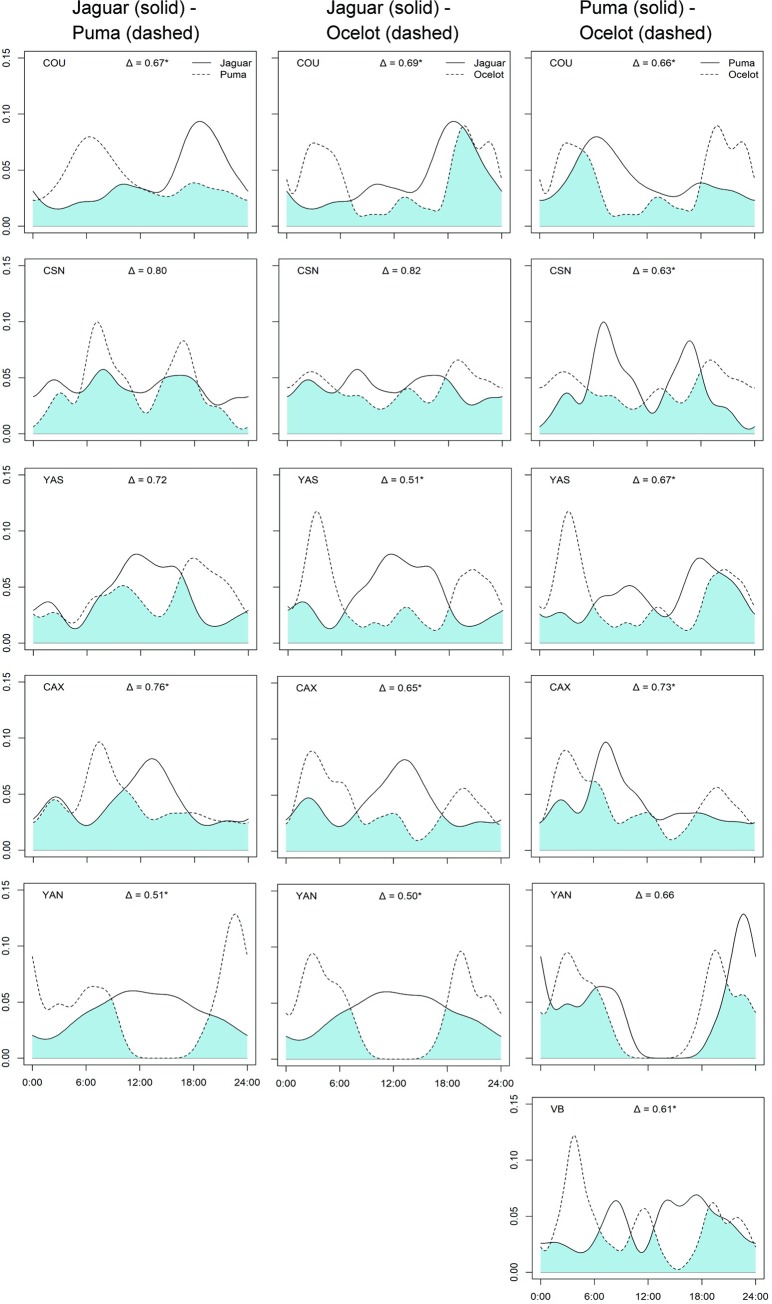
Coefficient of overlap in daily activity patterns between jaguar, puma and ocelot in Neotropical forest sites.X and Y axis represent time of the day and activity density, respectively. Overlap is represented by blue shaded areas and Δ is the coefficient of overlap (varying from 0 –no overlap to 1 –total overlap). (*) indicates significant differences. Study site is indicated in the top left corner.